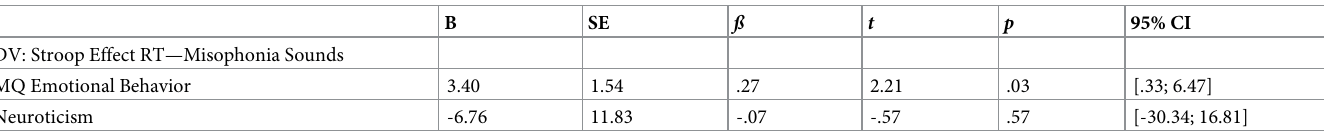
Table 2. Linear regression analysis predicting Stroop effect when exposed to misophonia